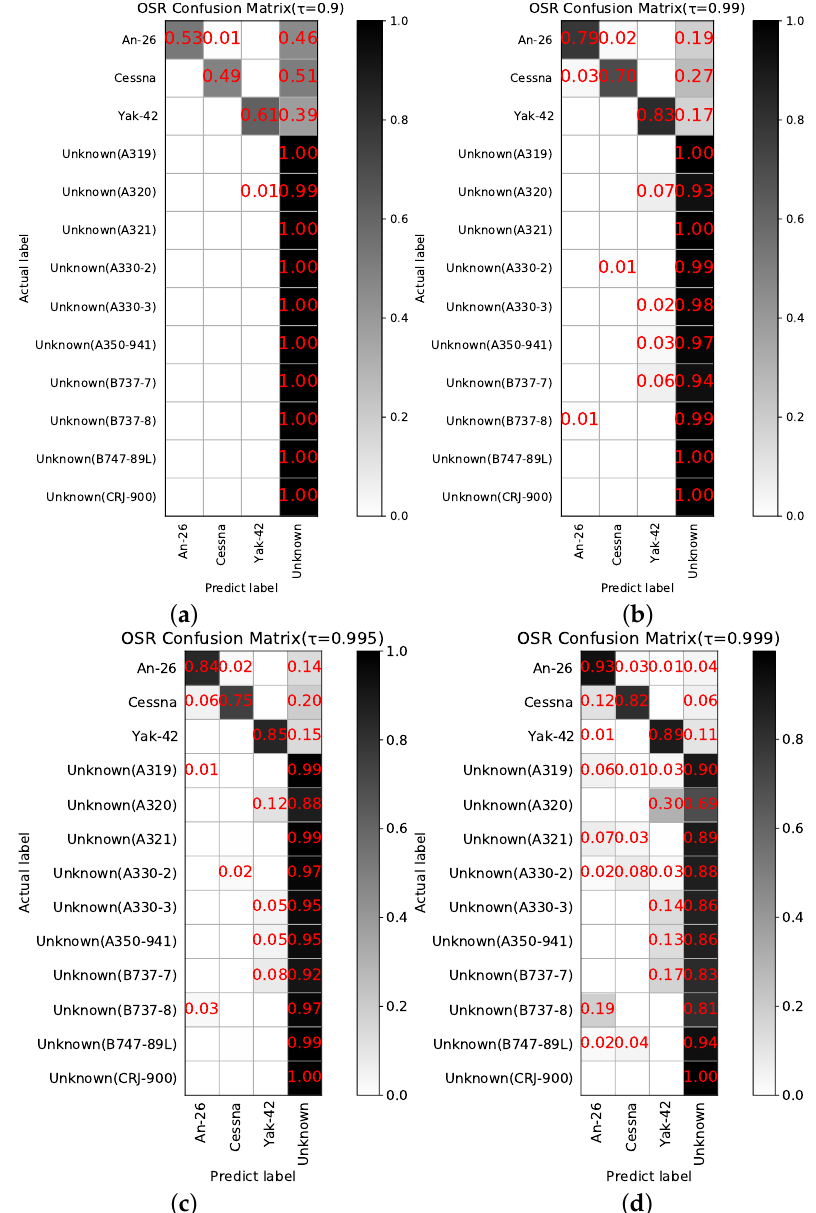
Figure 9. This figure shows several confusion matrices when the proposed method is combined with the Ring loss function (BD_Ring). ( a ) τ = 0.9; ( b ) τ = 0.99; ( c ) τ = 0.995; ( d ) τ =